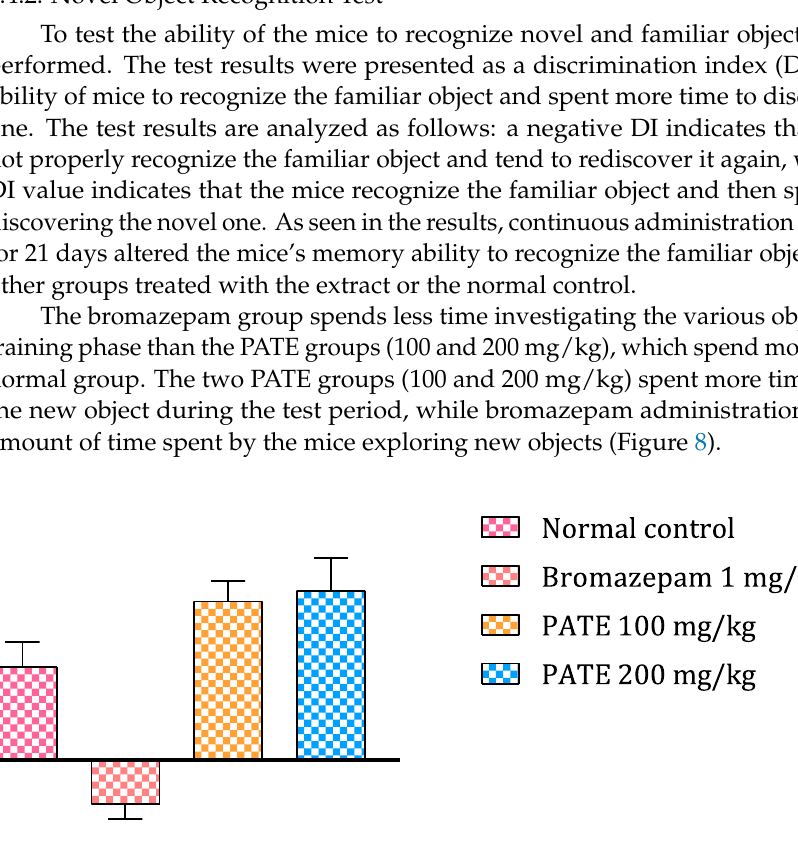
Figure 7. Effects of PATE in the MWMT. ( A ) Latency time and ( B ) time spent in the target quadrant. Data are represented as mean ± SEM. (** p ≤ 0.01, *** p ≤ 0.001 compared to the normal control group. ≠≠≠ p ≤ 0.001 compared to the positive control).